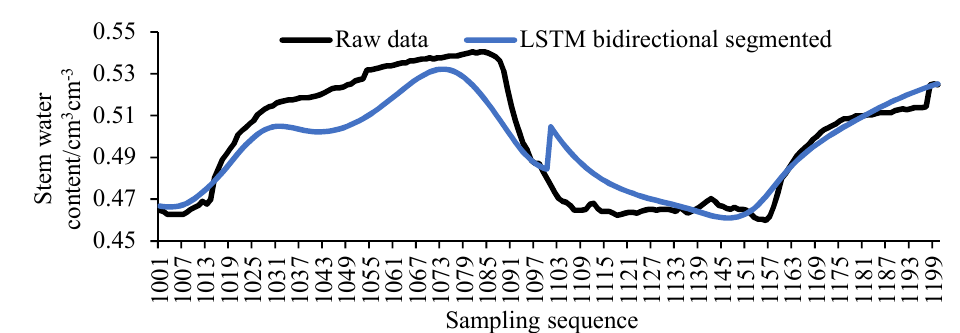
Figure 9. The LSTM bidirectional model.